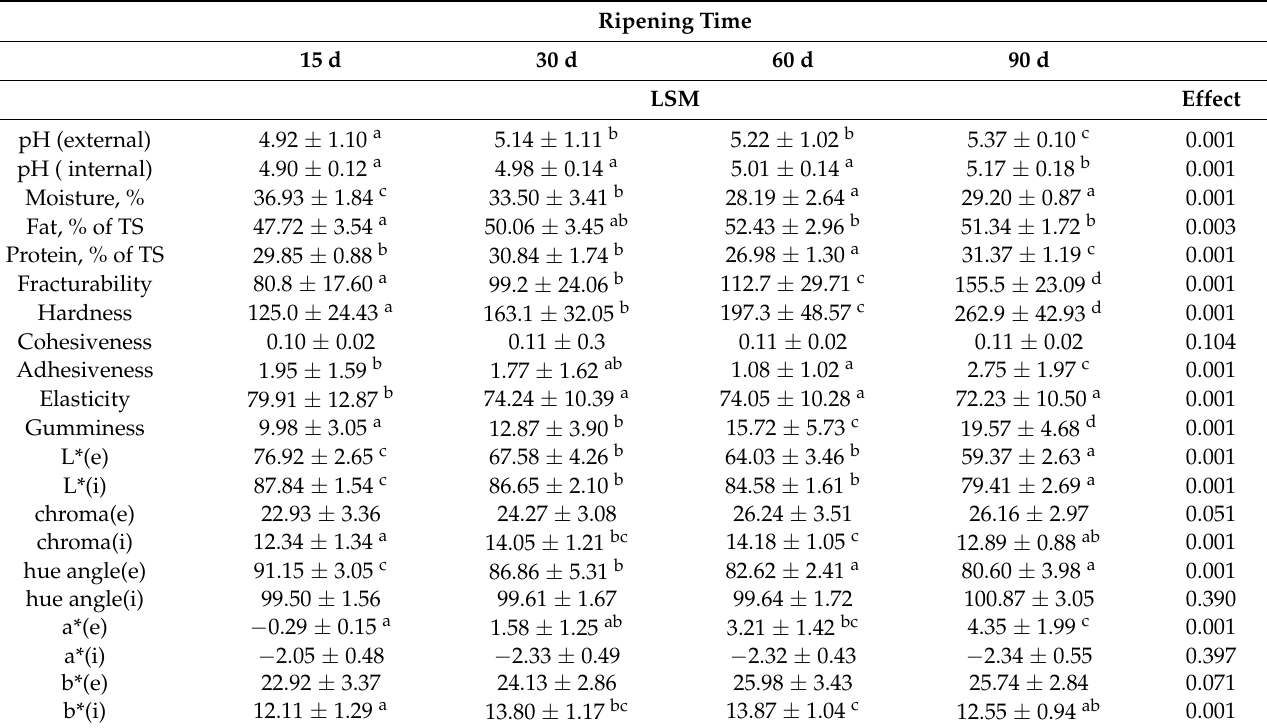
Table 1. Effects of ripening on physicochemical, instrumental texture and colour